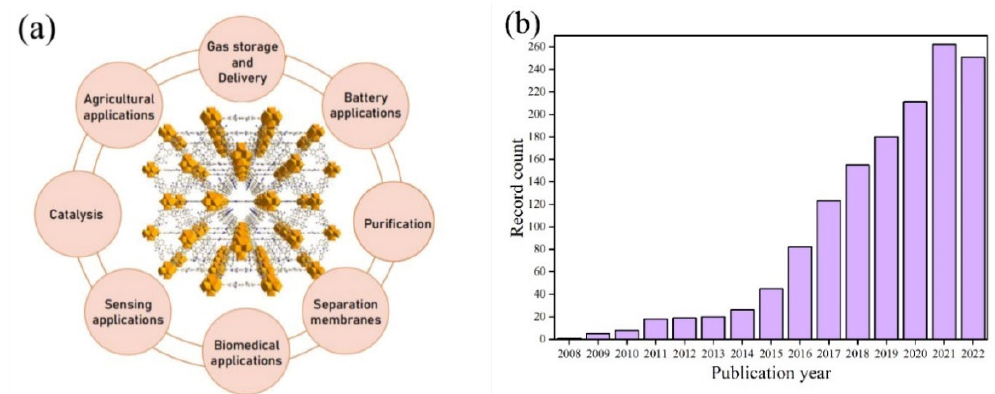
Figure 2. ( a ) Scheme showing a range of potential applications of MOFs. MOF image reproduced with permission from [46] ( b ) A graphical representation of the record count per year of publication, from a literature search on Web of Science (as in December 2022) for “MOFs” and “drug delivery”, indicating the rapid growth in interest in this area of research.